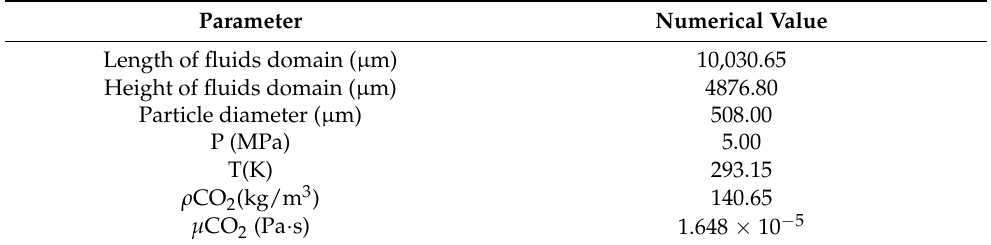
Table 1. Basic parameters of the pore-scale